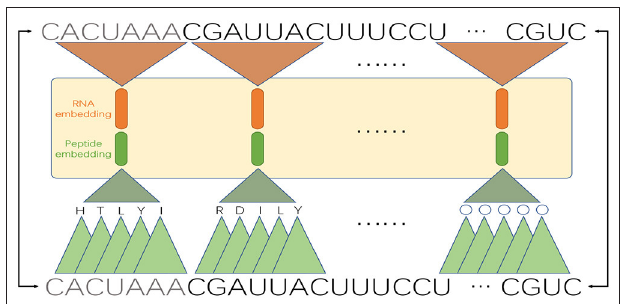
FIGURE 2 | An example of double embeddings. An RNA sequence is segmented into 7-mers, and each 7-mer is converted into an embedding vector; meanwhile, the 7-mer is mapped to a pseudo-peptide, which is also converted into an embedding vector. The two embedding vectors are concatenated as a whole